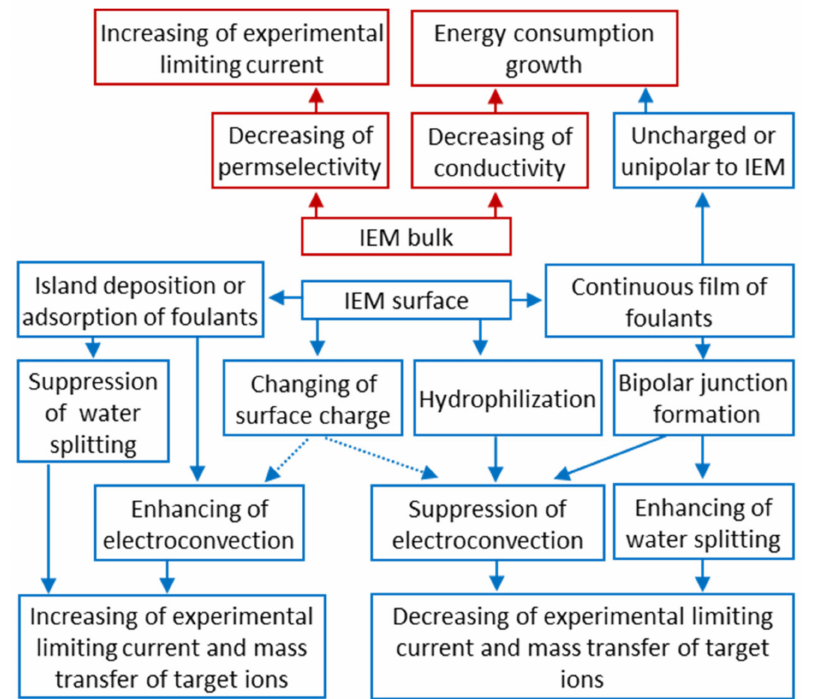
Figure 14. Schematic representation of the changes in the bulk and surface of IEMs caused by fouling and the effect of these changes on the most important characteristics of membrane processes in the applied electric field and in its absence. Reproduced from